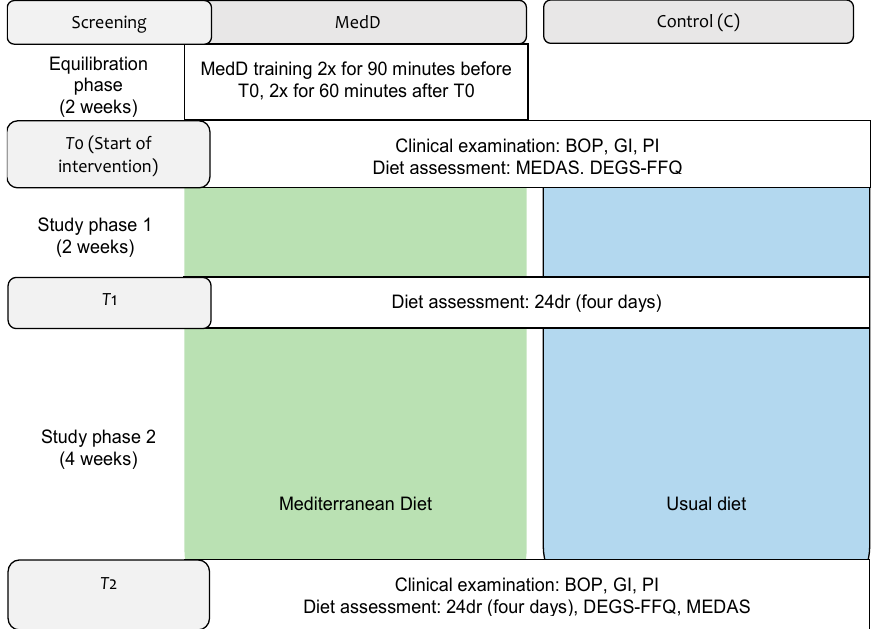
n=42 allocated to MedD or C group n=18 analyzed: T 0: clinical data n= 18; FFQ n=18; MEDAS n=18 T 1: 24dr n=12 T 2: clinical data n=18; FFQ n=18; MEDAS n=18; 24dr n=12 n=19 allocated to control n=19 analyzed: T 0: clinical data n=19; FFQ n=19; MEDAS n=19 T 1: 24dr n=12 T 2: clinical data n=19; FFQ n=19; MEDAS n=18; 24dr n=12 n=2 declined further participation n=23 allocated to MedD  n=3 denied participation due to coronavirus pandemic